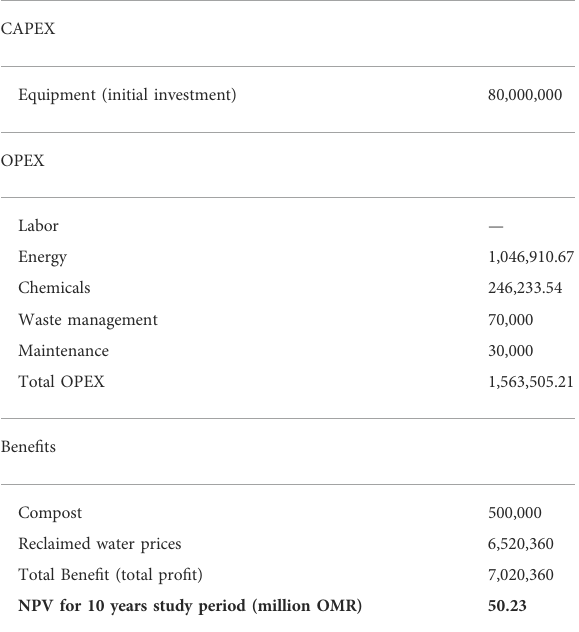
TABLE 6 Prices from the Al ansab STP. Source: (OWWSC). Conventional method (irrigation, cooling, and utility) (OMR/ year)